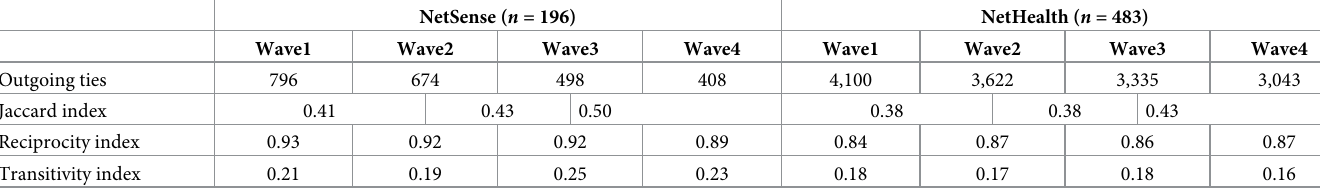
Table 5. Summary statistics of social networks among NetSense and NetHealth study